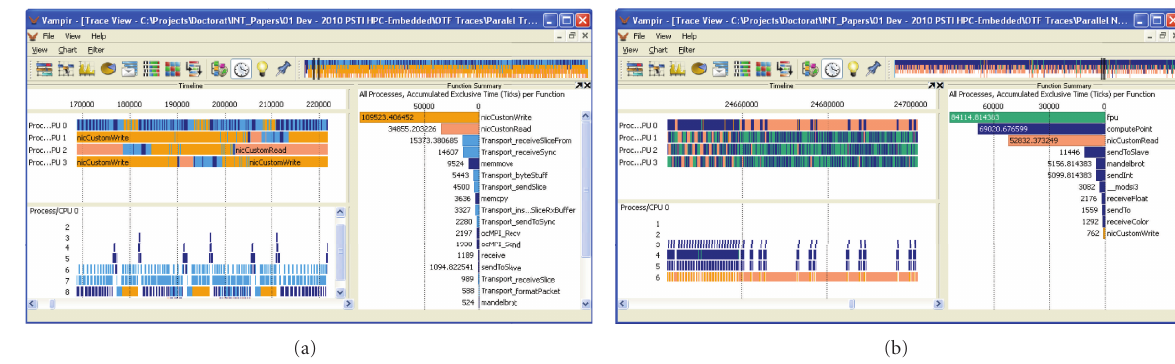
Figure 6: Performance optimization process of a parallel Mandelbrot application. (a) Trace visualization of the initial version. (b) Trace visualization of the optimized version.